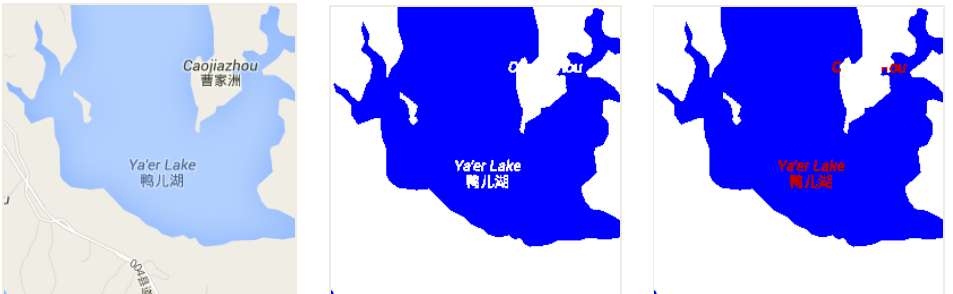
Figure 11. Water-area hole filling.